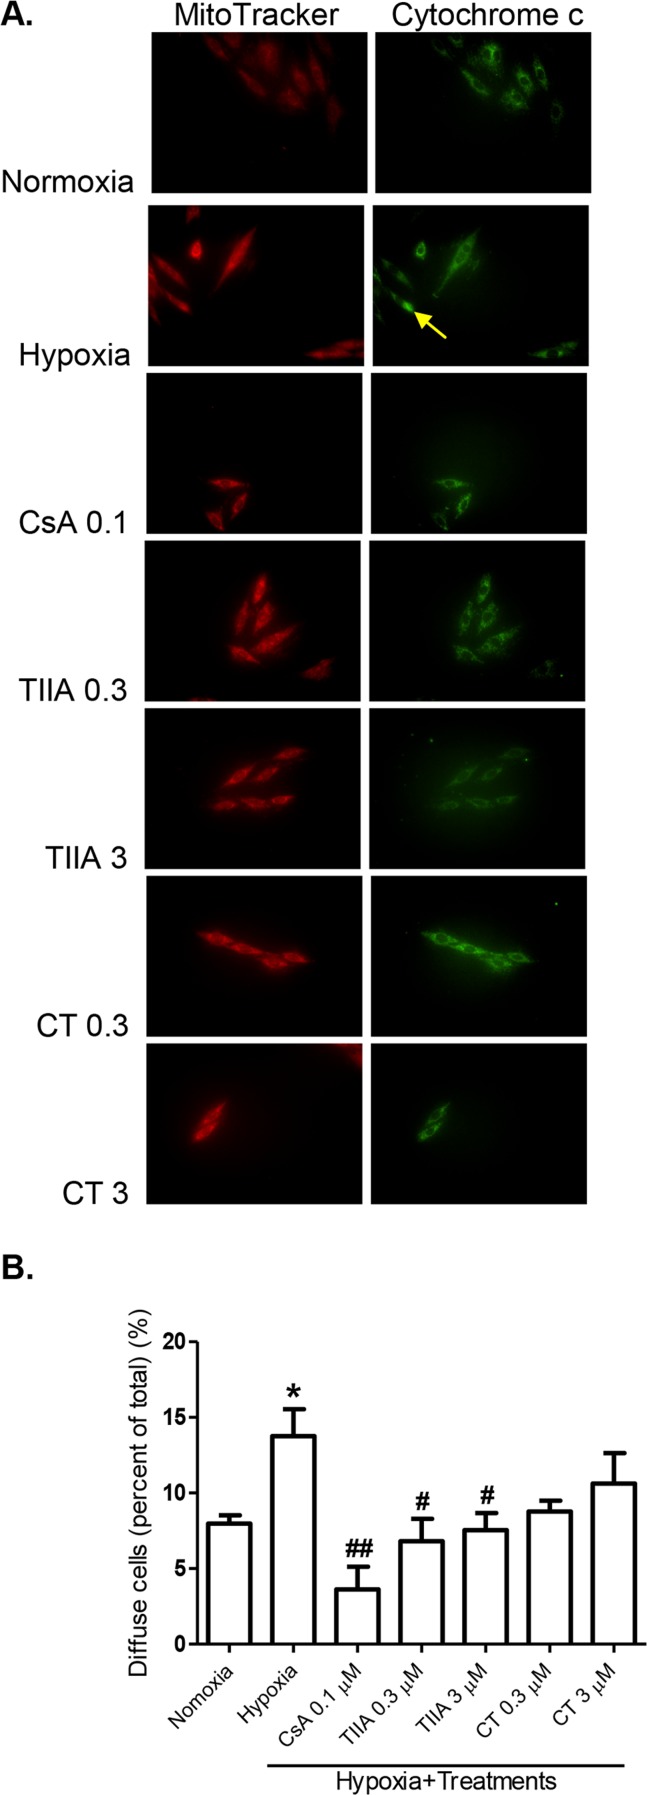
Effects of TIIA, CT and CsA on hypoxia induced cytochrome c translocation. (A) Cell images illustrate mitochondria labelling with MitoTracker Orange CMTMRos (MitoTracker) (red) and cytochrome c (green) in H9c2 cells under normoxia and hypoxia conditions, and the effects of TIIA, CT and CsA treatments (yellow arrow: cytochrome c release). (B) Quantitative data of cytochrome c diffusion rate. H9c2 cells were scored as having cytochrome c in mitochondria defined by punctuate (no cytochrome c release) or cytochrome c release to cytosolic distinguished by diffused staining and overtaking mitochondrial staining. Mean data from 500 cells per group in 3 independent experiments. * P<0.05 vs. normoxia, # P<0.05 vs. hypoxia, ## P<0.01 vs. hypoxia.